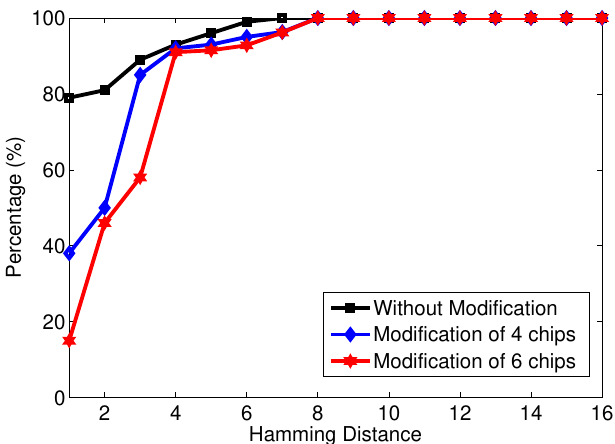
Figure 15. CDF of Hamming